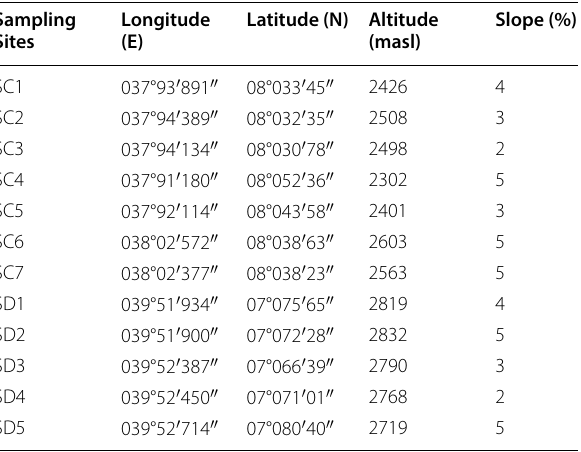
Table 1 Sampling locations and site